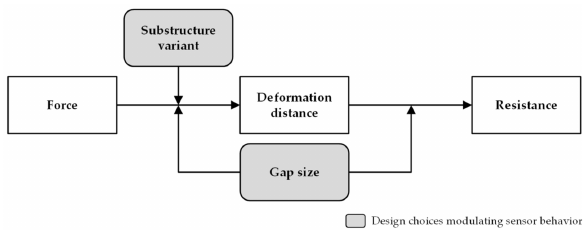
Figure 12. Chart showing the relationship between influencing factors in sensor behavior. The deformation distance in turn is related to the applied force, and affected by the gap size and the stiffness of the substructure variant used. The gap size influences the amount of physical interference, and thereby force, required for deformation, while a stiffer substructure directly resists deformation and affects the force-displacement